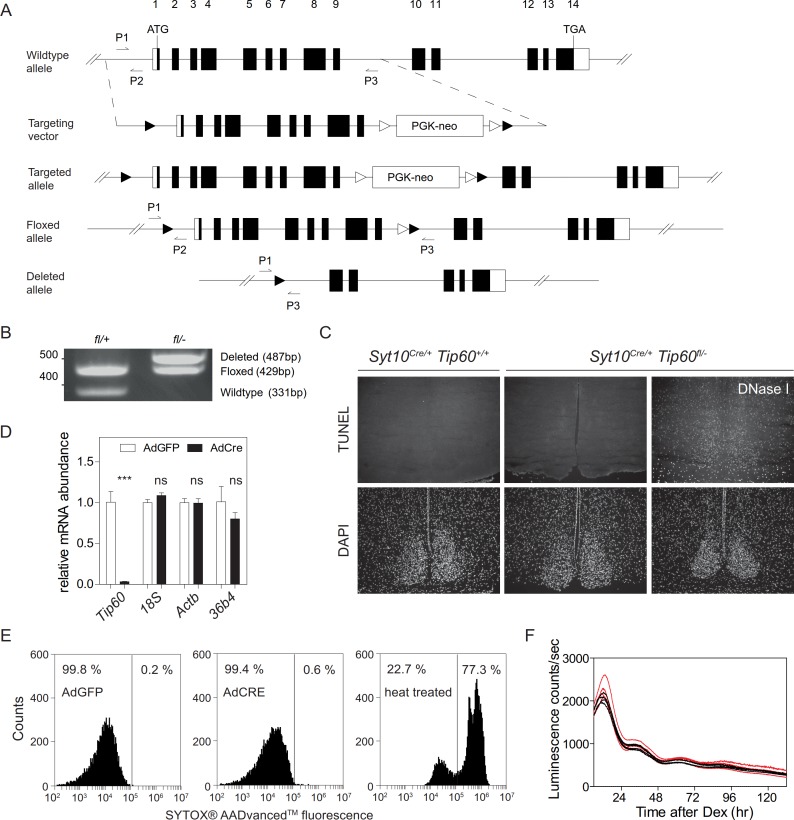
Generation and validation of the Tip60-deficient mice and MEFs derived from such animals.(A) Targeting strategy for the Tip60 locus. Tip60 wildtype allele, targeting vector, targeted allele, floxed allele after removal of the PGK-Neo cassette, and the mutant Tip60 allele created by Cre-mediated recombination are shown. LoxP (black triangle) and FRT (open triangle) sites are marked. The arrows indicate the position of diagnostic primers P1-P3 (see Supplementary file 1). (B) PCR genotyping of Tip60 alleles. The wildtype allele produces a 331 bp amplicon (primers P1, (P2) while the floxed allele produces a 429 bp amplicon (P1, P2). Deletion of the LoxP-flanked region of the Tip60 locus leads to a 487 bp fragment (P1, P3). (C) TUNEL immunoreactivity on brain sections of Syt10Cre/+Tip60+/+ (control), arrhythmic Syt10Cre/+Tip60 fl/- animals, and Syt10Cre/+Tip60 fl/- sections treated in situ with DNase I. (D) mRNA expression of housekeeping genes in Tip60fl/- MEFs transduced with either AdGFP or AdCre, 24 hr after Dex synchronization. Data are mean ± SD (n = 3; ns > 0.05 and ***p<0.001, Student’s t-test). (E) Flow cytometric analysis of AdGFP, AdCre transduced, and heat-treated (3 min, 95°C) confluent Tip60fl/- MEFs. (F) Bioluminescence tracing of Dex-synchronized Bmal1-LUC MEFs transduced with AdGFP (black) or AdCre (red) (n = 4).